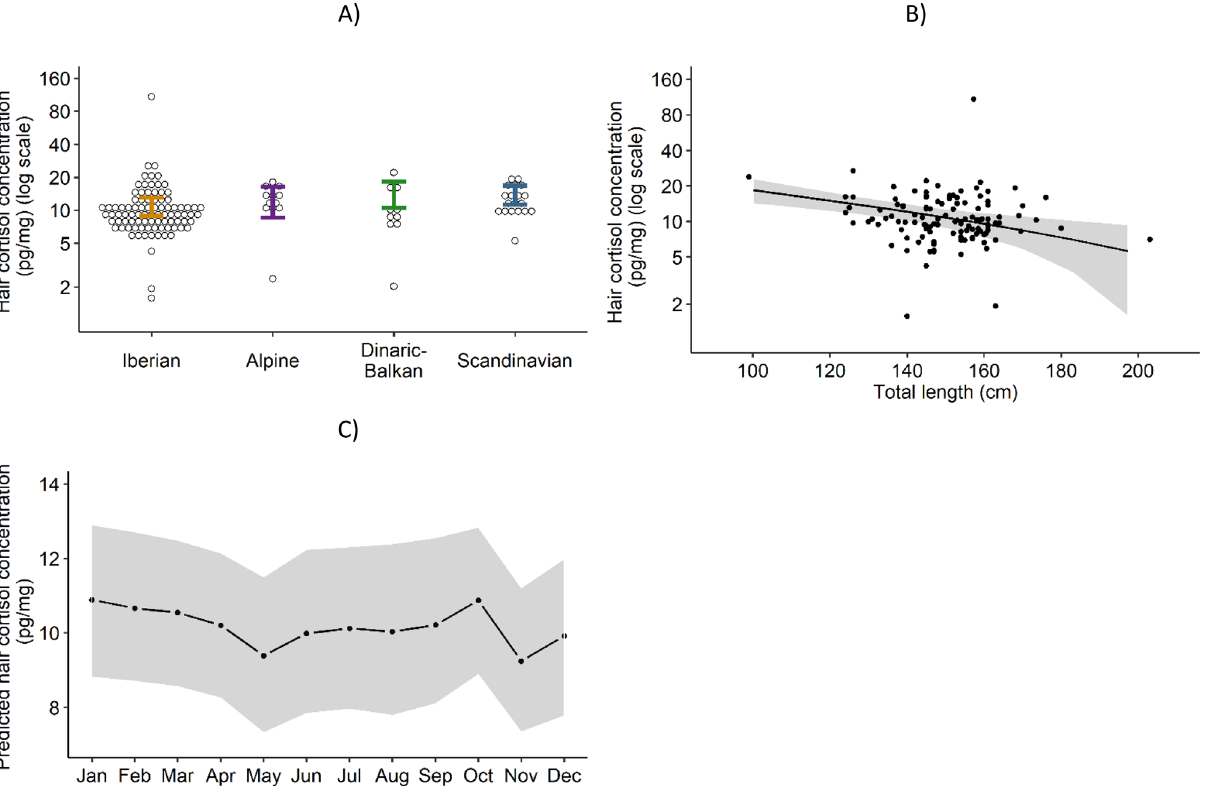
Figure 3. Hair cortisol concentration observed and predicted by the linear mixed model. Hair cortisol concentration by: ( A ) wolf population: observed (dots) and predicted by the linear mixed model (95% confidence interval as colored error bars). ( B ) Total length: observed (dots) and predicted by the linear mixed model with 95% confidence interval as shaded grey area. ( C ) Month: 95% confidence interval as shaded grey area. Predictions of the most supported model for wolves of the reference classes, 95% confidence intervals include fixed and random effects.